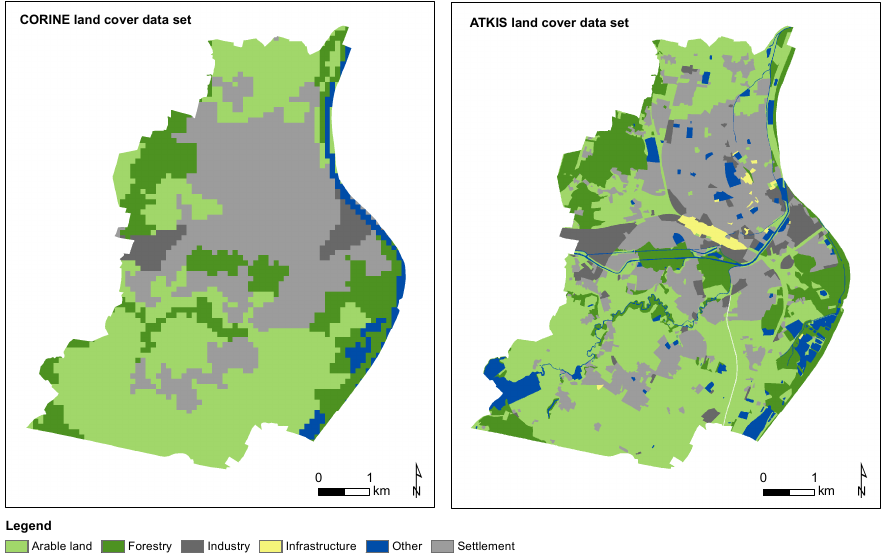
Figure 8. Classification of the study site into the damage categories of the Rhine Atlas model based on the CORINE and ATKIS land cover data set (CLC 2006, ATKIS ® -Basis-DLM 2008).